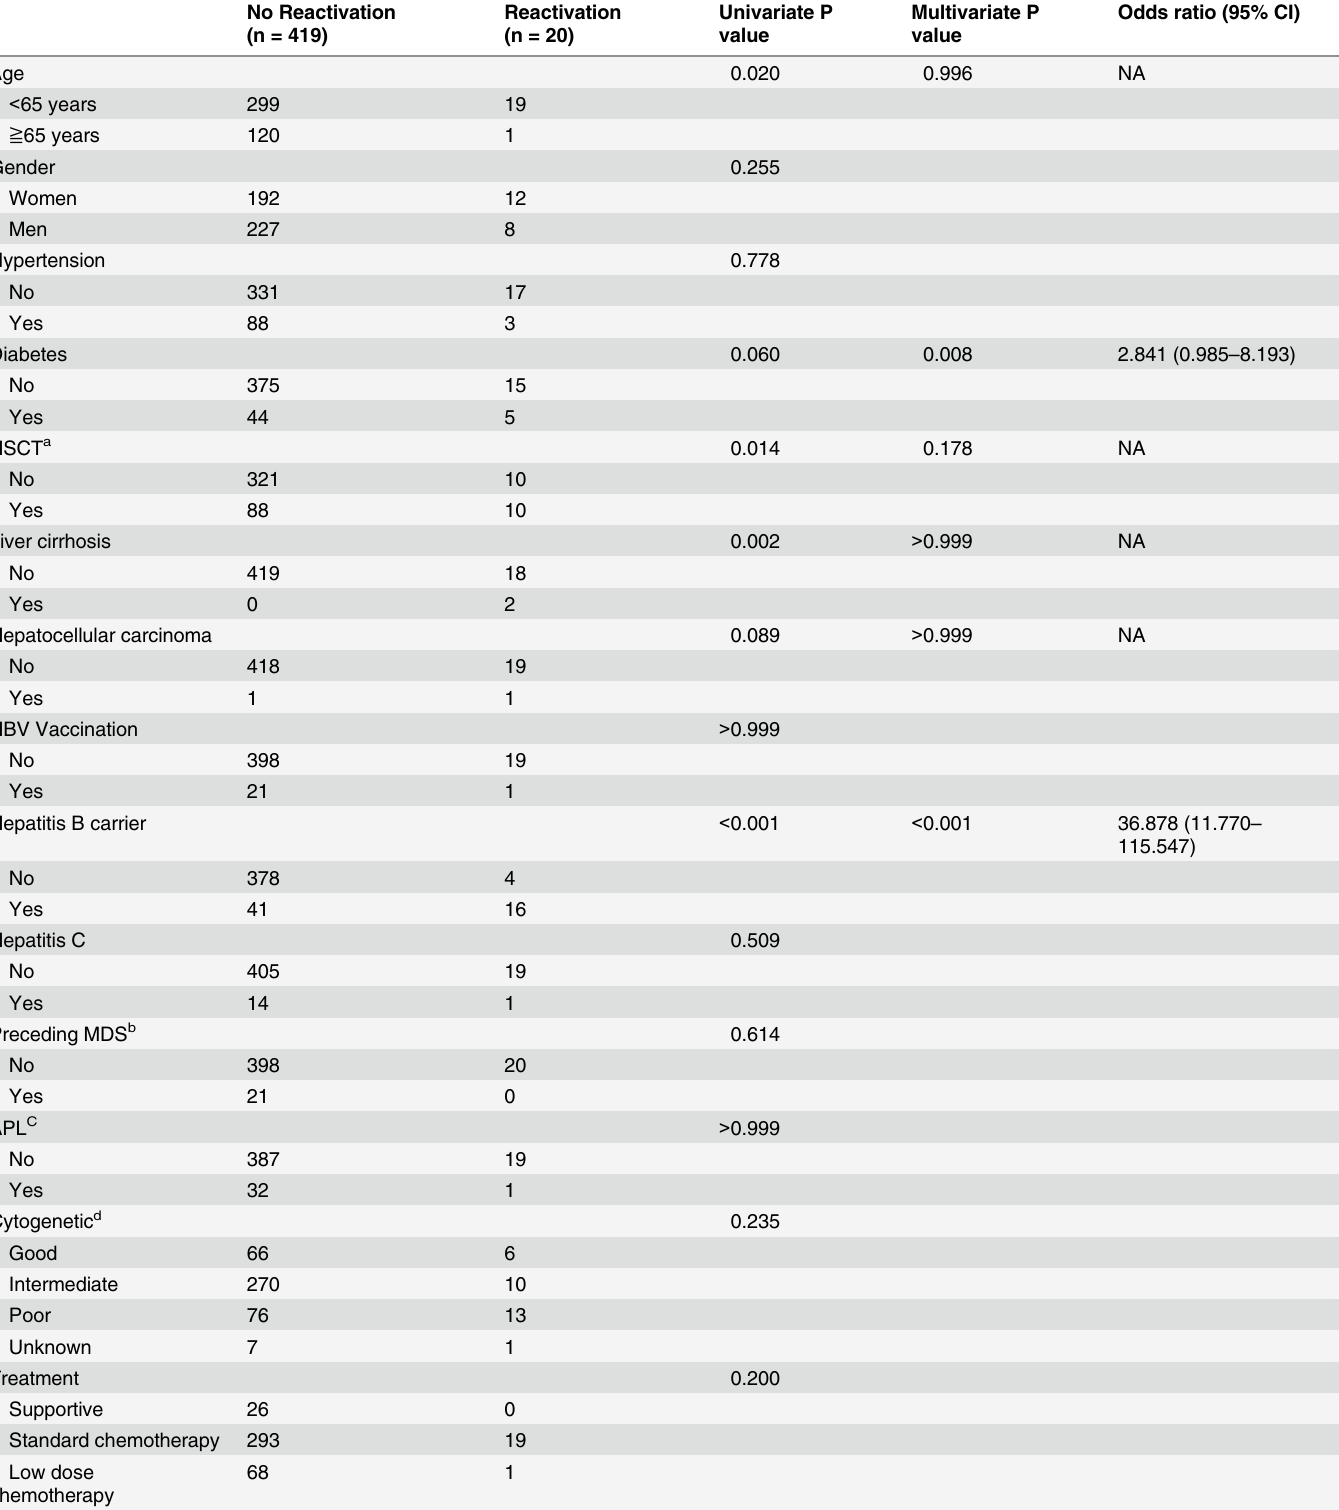
Table 2. Overall risk factors for hepatitis B reactivation in 439 acute myeloid leukemia patients *